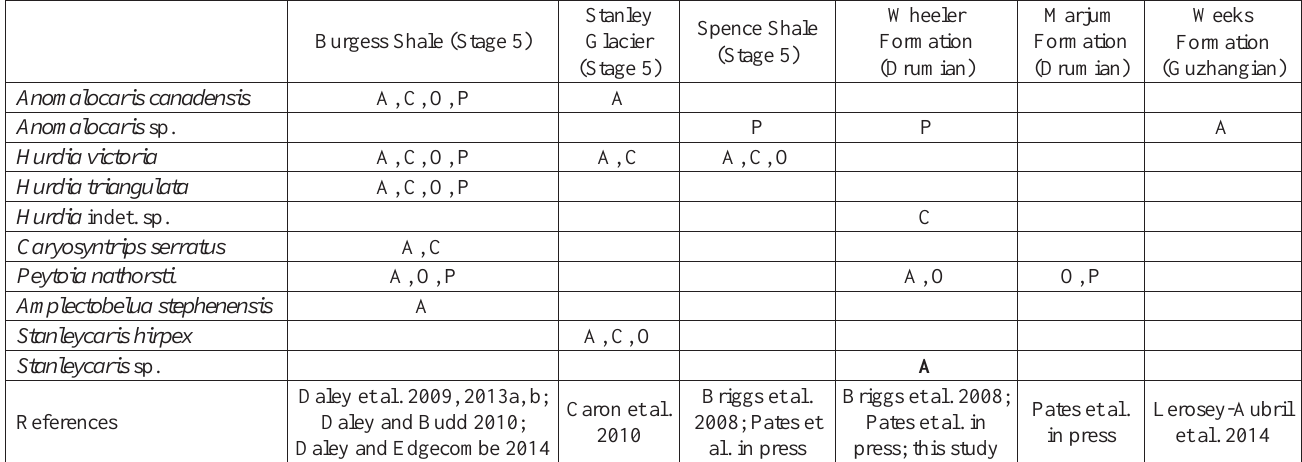
Table 2. Diversity of Cambrian radiodontans from Canada and Utah. A, appendage; C, carapace element; O, oral cone; P, post cephalic